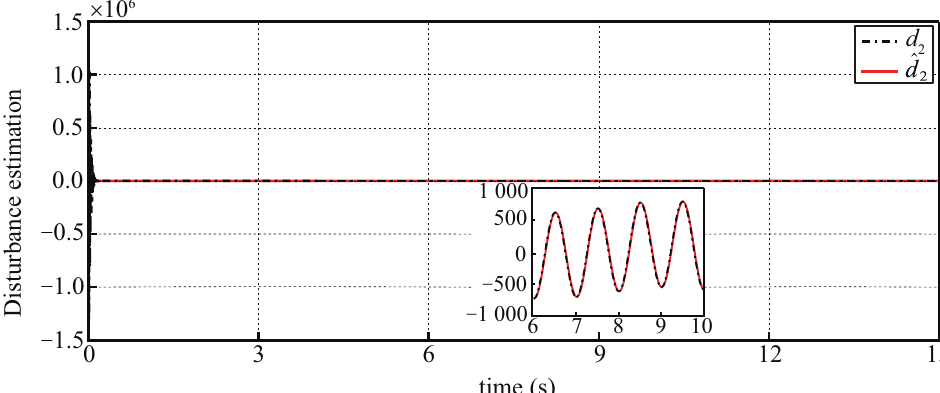
Figure 7. Estimation performance of d 2 via RESO.